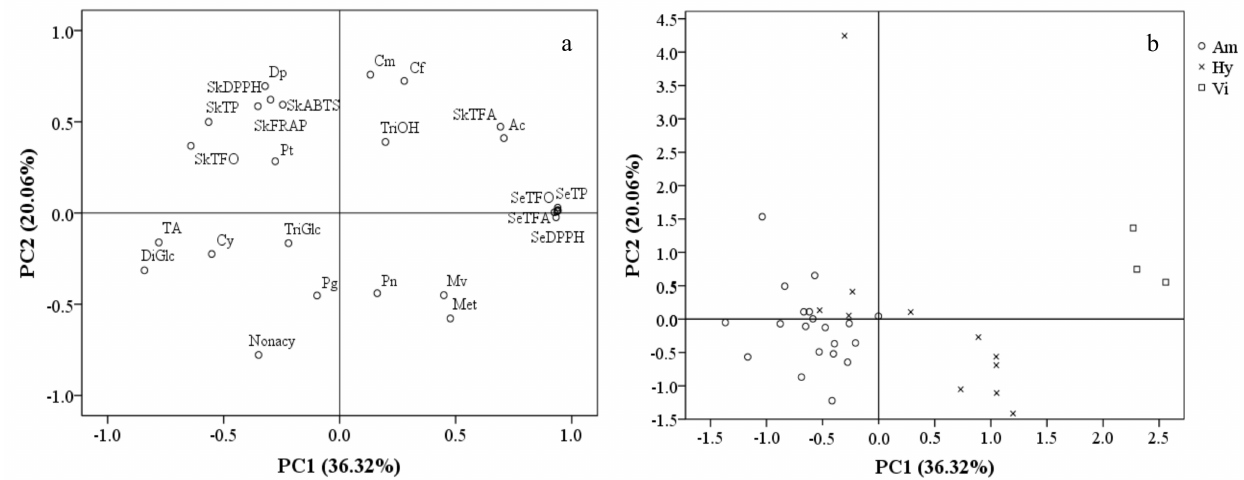
Figure 5. Distribution patterns of 27 variables ( a ) and 34 cultivars/accessions belonging to the three grape groups ( b ) 2017 and 2018 in the two − dimensional space of PC1 and PC2. The abbreviations of variable and grape groups follow Figures 1, 2 and